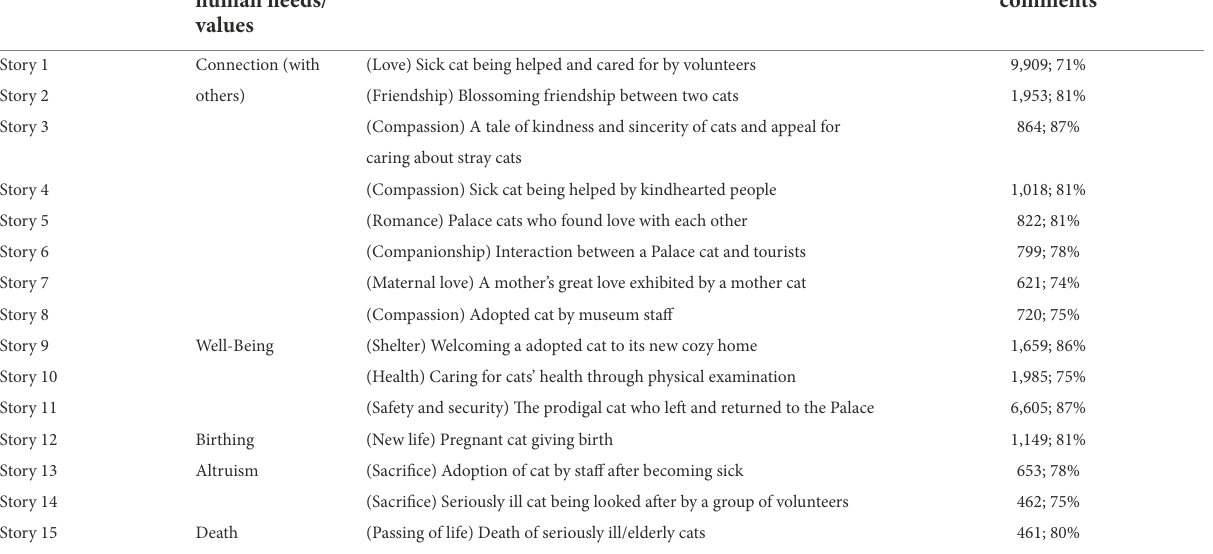
TABLE 3 Themes in 15